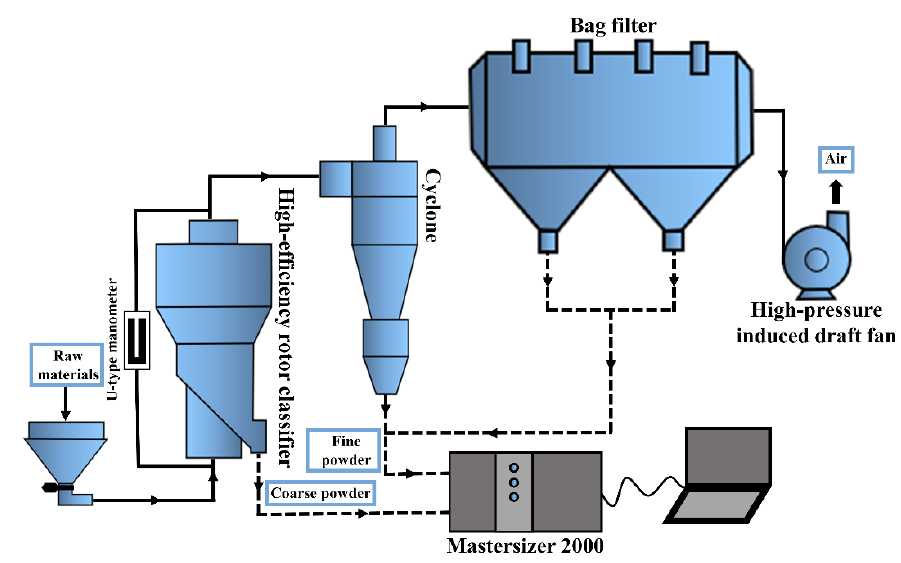
Figure 4. Scheme for the experimental setup.